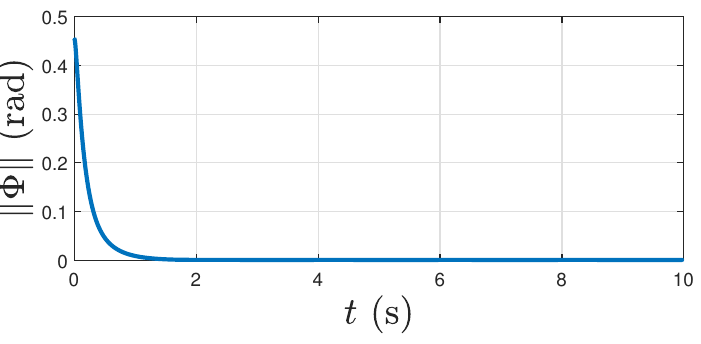
Figure 8. Principal angle of attitude tracking error versus